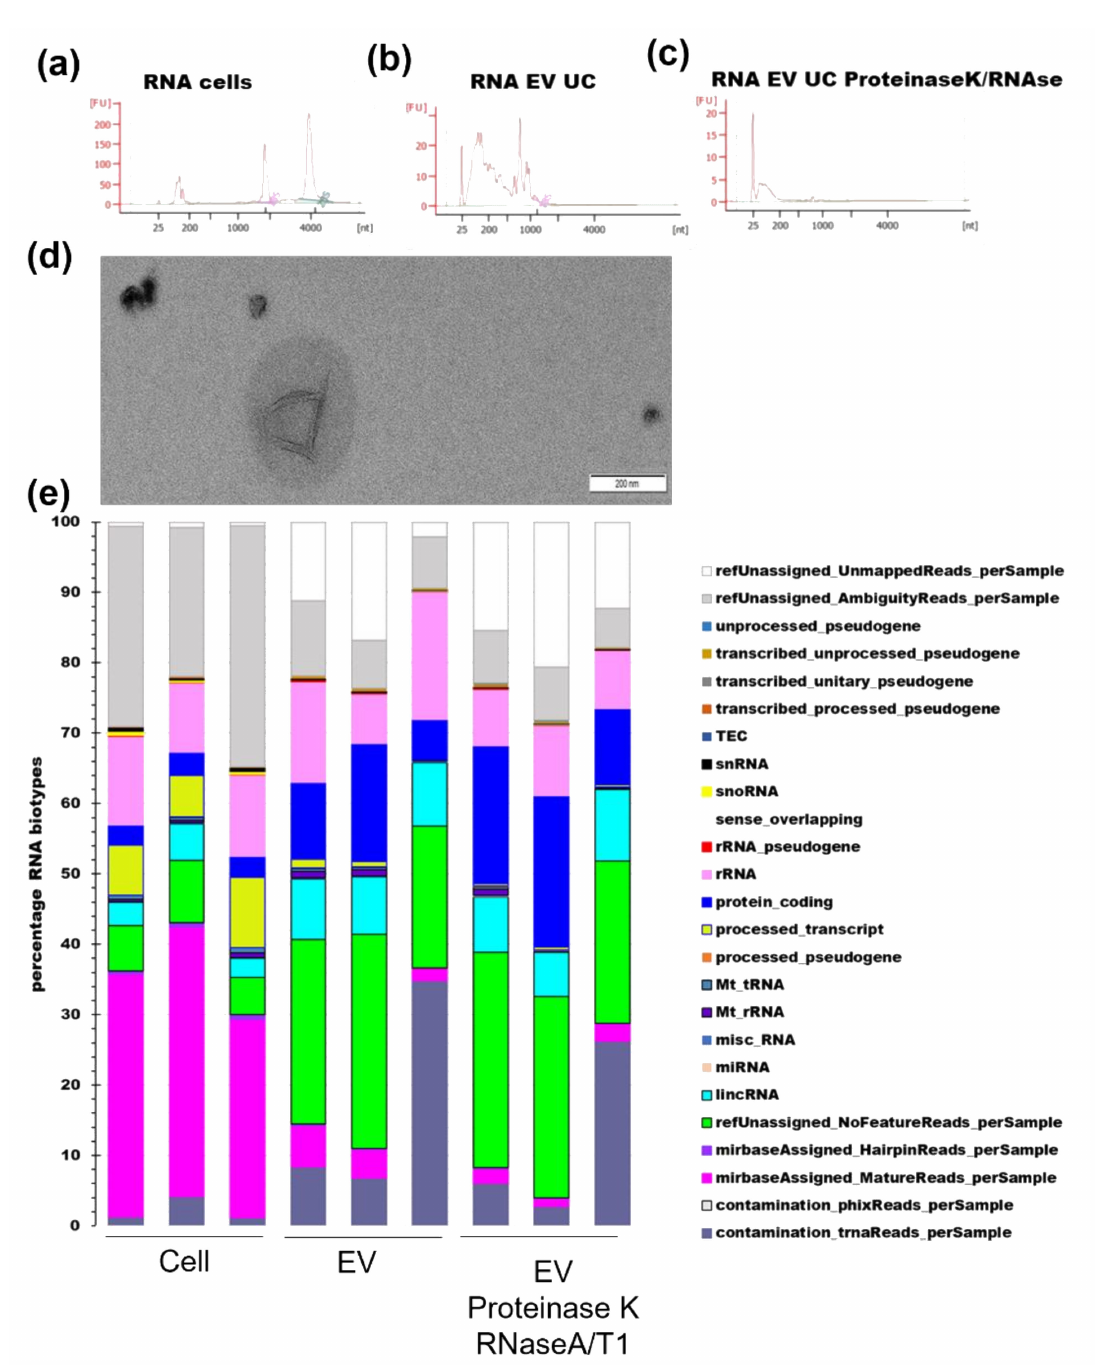
Figure 5. Bioanalyzer profiles of RNA extracted from ( a ) cells, ( b ) EVs, and ( c ) EVs treated with proteinase K and RNase A/T1. ( d ) TEM image of EVs treated with proteinase K and RNase A/T1. ( e ) miRNA-seq RNA biotype distribution per